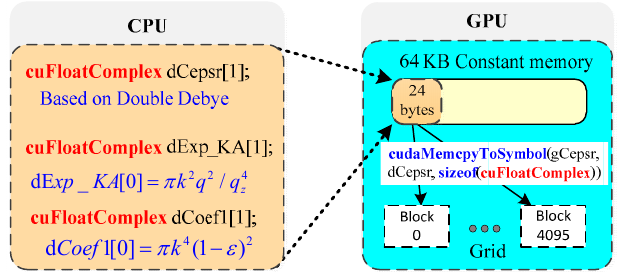
Figure 9. Schematic of the usage of constant memory for avoiding repeated calculations during the kernel execution.